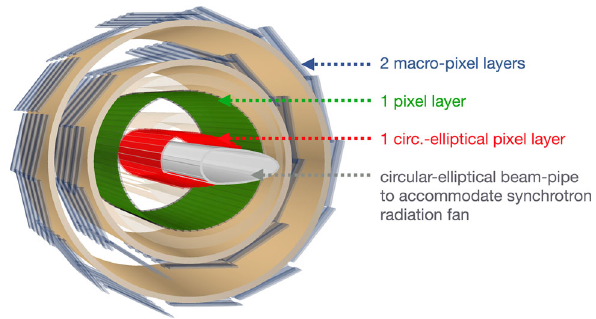
Fig. 7 A view of inner 4 layers of central barrel tracker with innermost circular-elliptical silicon pixel layer following the shape of beampipe